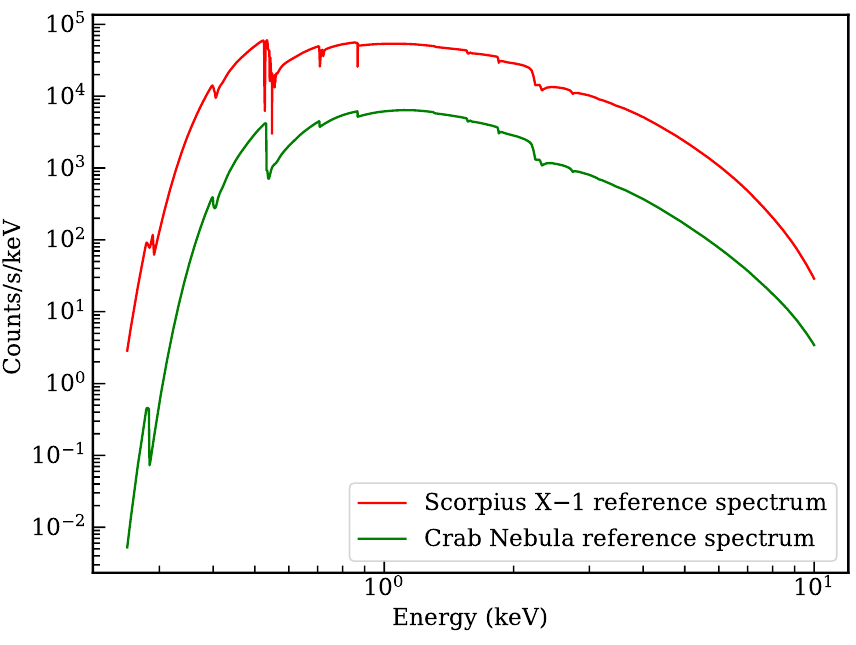
Figure 5. Comparison of reference energy spectrum of Scorpius X–1 and the Crab Nebula. The solid red line shows the reference spectrum of Scorpius X–1 and the solid green line shows the reference spectrum of the Crab Nebula. It is found that the spectral count rate of Scorpius X–1 is about an order of magnitude higher than that of the Crab